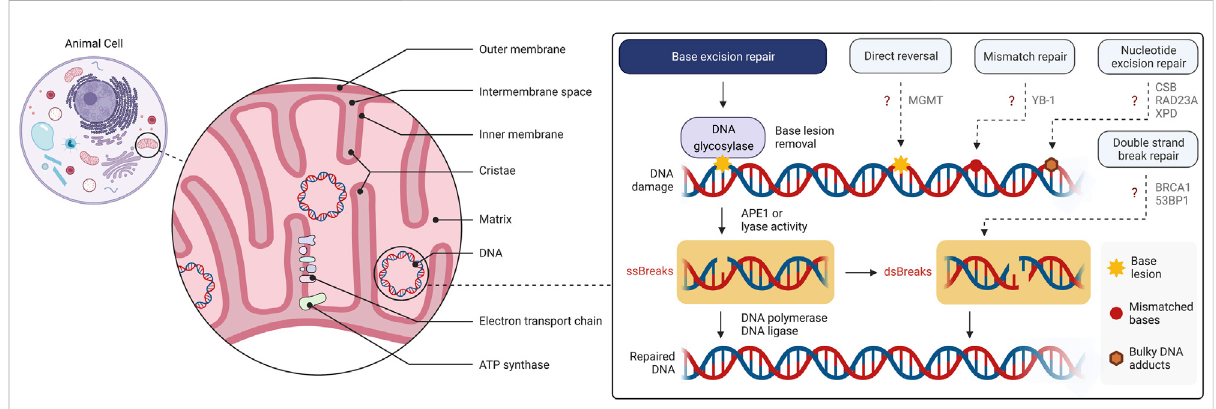
FIGURE 1 Overview of the mitochondrial structure and mtDNA damage and repair. Base excision repair (BER) is the primary mtDNA repair pathway. CanonicalformsofthenuclearDNArepairpathways,mismatchrepair(MMR),nucleotideexcisionrepair(NER),directreversal(DR)anddoublestrand break repair (DSBR), have not been demonstrated to operate in mitochondria although individual enzymes of these pathways may be present. The fi gure has been generated using